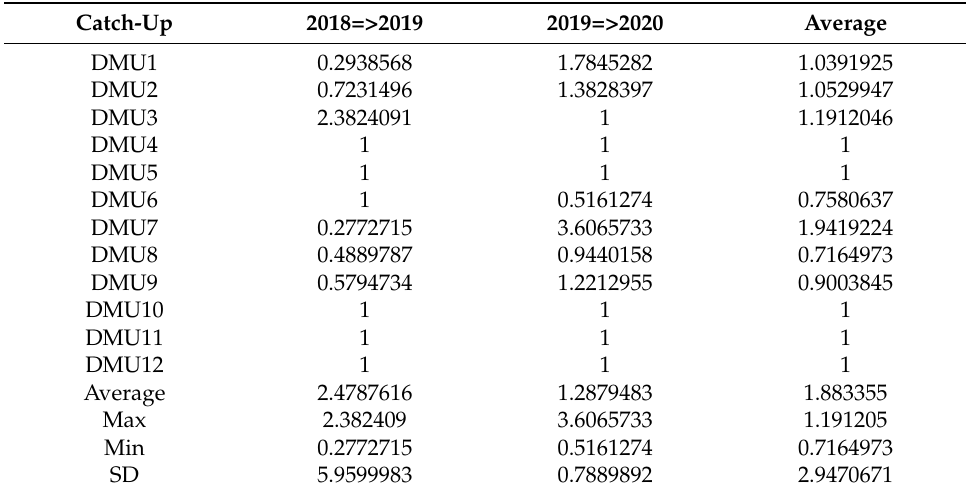
Table 12. The efficiency (catch-up) changes level over the period from 2018 to 2020. Catch-Up